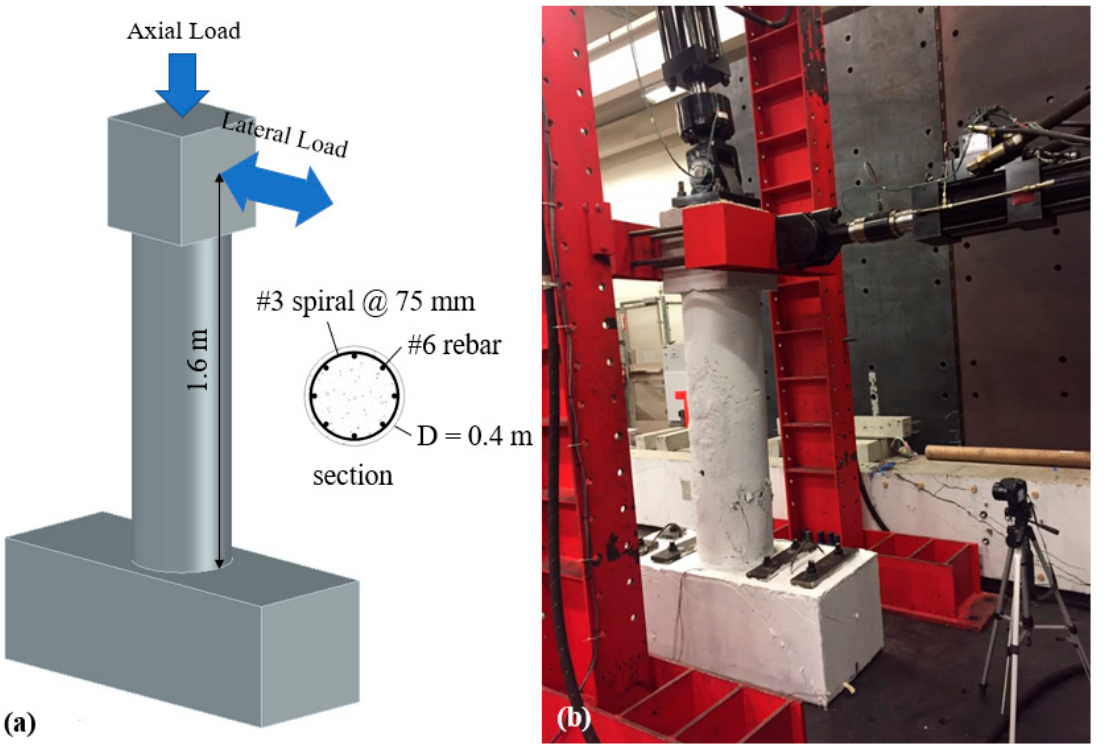
Figure 4. Column test ( a ) geometry and loading configuration and ( b ) test setup.